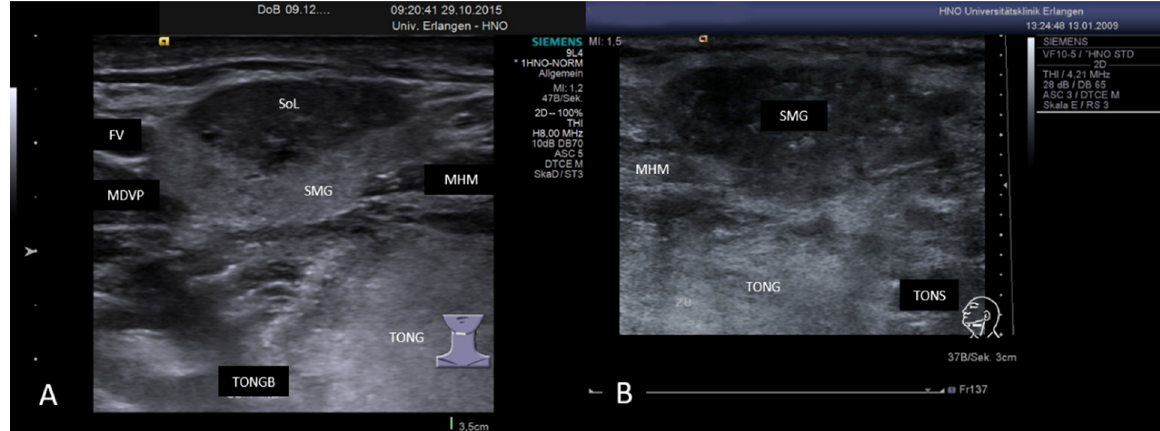
Figure 17. ( A , B ) Sclerosing IgG-4-related sialadenitis in two SMGs. In ( A ), the caudal part of the right-sided SMG is characterized by a mixed hypoechoic to anechoic and hyperechoic tissue pattern. In ( B ), the whole gland is changed in this way. A functioning parenchyma is no longer visible. Clinical diagnosis was first presence of a “Küttner’s tumor”. Abbreviations: SMG, submandibular gland; MHM, mylohyoid muscle; MDVP, digastric muscle venter posterior; TONG, tongue;